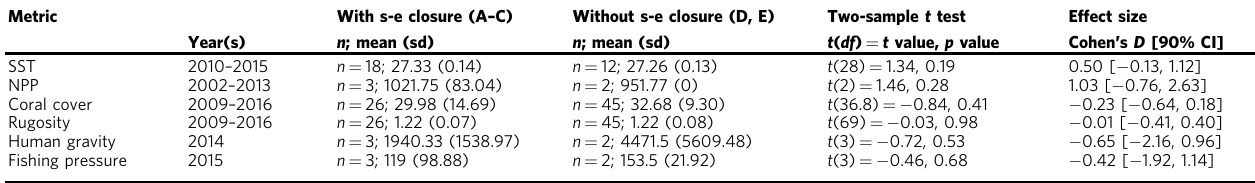
Table 1 Biophysical, environmental, and human impact characteristics Metric